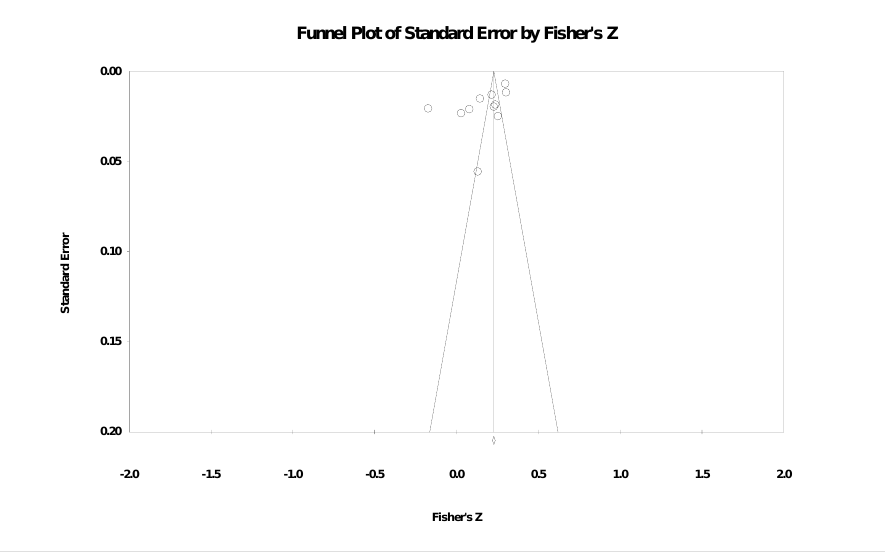
Figure 5. Funnel plot of the association between AFEs and mental well-being.